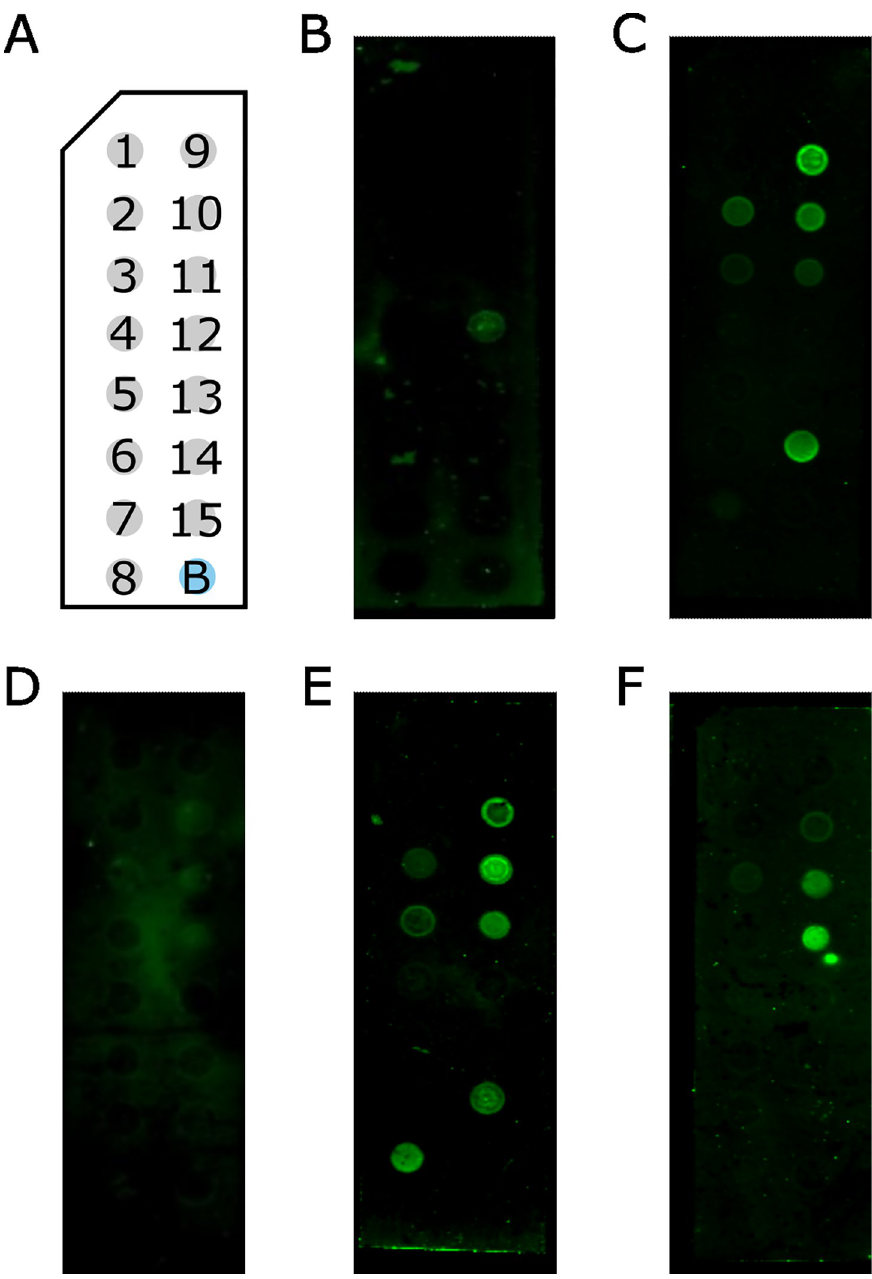
Fig 6. Annexin-lipid binding. (A) Membrane Lipid Strip (Echelon) schematic. 1 –Triglyceride, 2 –Diacylglycerol (DAG), 3 –Phosphatidic acid (PA), 4 –Phosphatidylserine (PS), 5 –Phosphatidylethanolamine (PE), 6 – Phosphatidylcholine (PC), 7 –Phosphatidylglycerol (PG), 8 –Cardiolipin, 9 –Phosphatidylinositol (PI), 10 – Phosphatidylinositol-4-phosphate (PIP), 11 –Phosphatidylinositol-4-5-bisphosphate (PIP 2 ), 12 –Phosphatidylinositol- 3-4-5-trisphosphate (PIP 3 ), 13 –Cholesterol, 14 –Sphingomyelin, 15–3-sulfogalactosylceramide (sulfatide), B–Blank. (B) Annexin with 1 mM EDTA, low-level binding to PIP 3 . (C) Annexin with 1 mM CaCl 2 binding to PIP, PIP 2 , PIP 3 , PA, PS & sulfatide. (D) Annexin with 20% TRD and 1 mM EDTA showing very low-level binding to PIP, PIP 2 , PIP 3 , PA. (E) Annexin with 20% TRD binding to PIP, PIP 2 , PIP 3 , PA, PS, sulfatide & cardiolipin. (F) Annexin with 10% GRD binding to PIP 2 , PIP 3 with low-level binding to PIP &